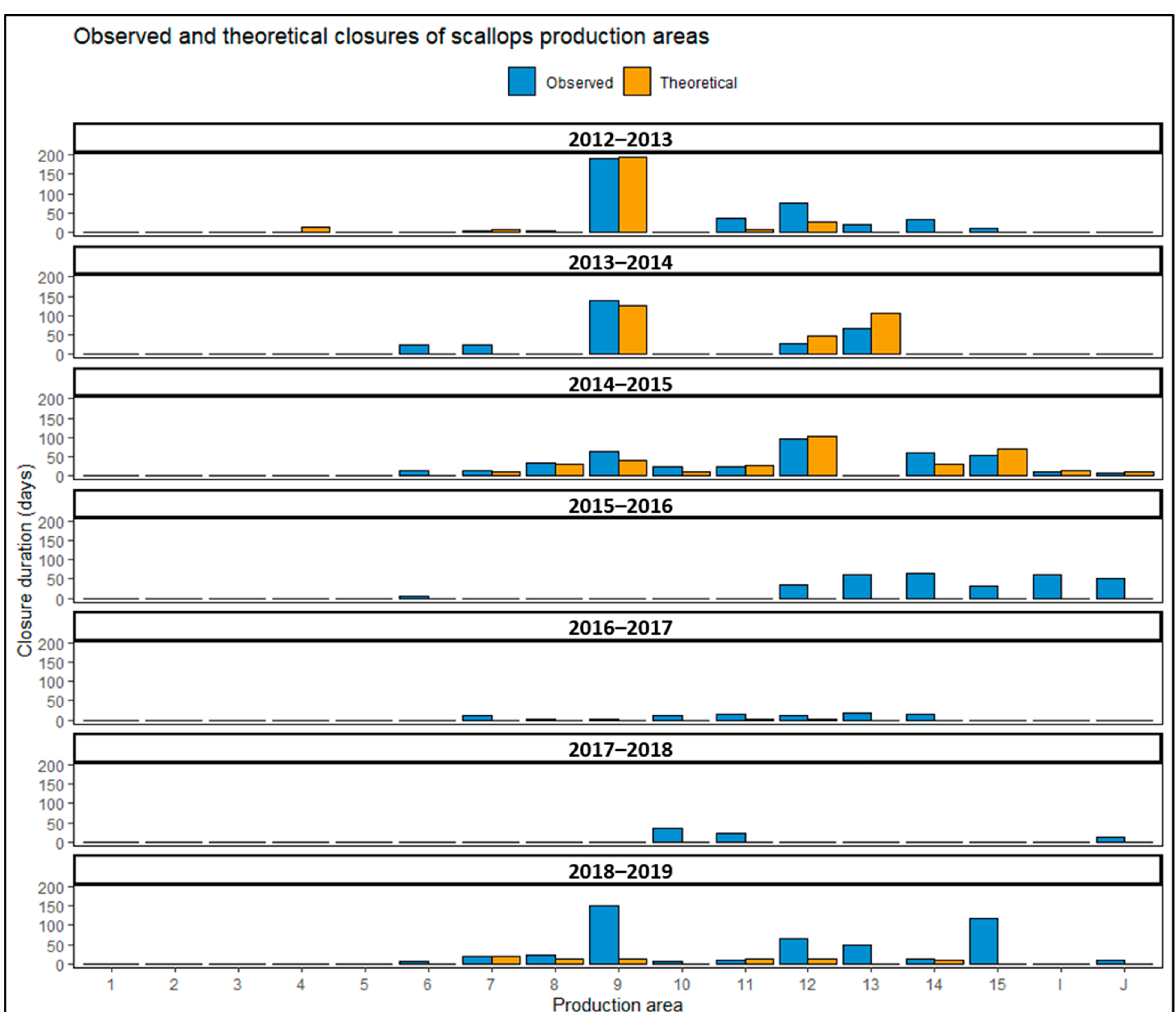
Figure 5. Comparison of theoretical and observed closures duration in scallop production areas in the eastern Channel.